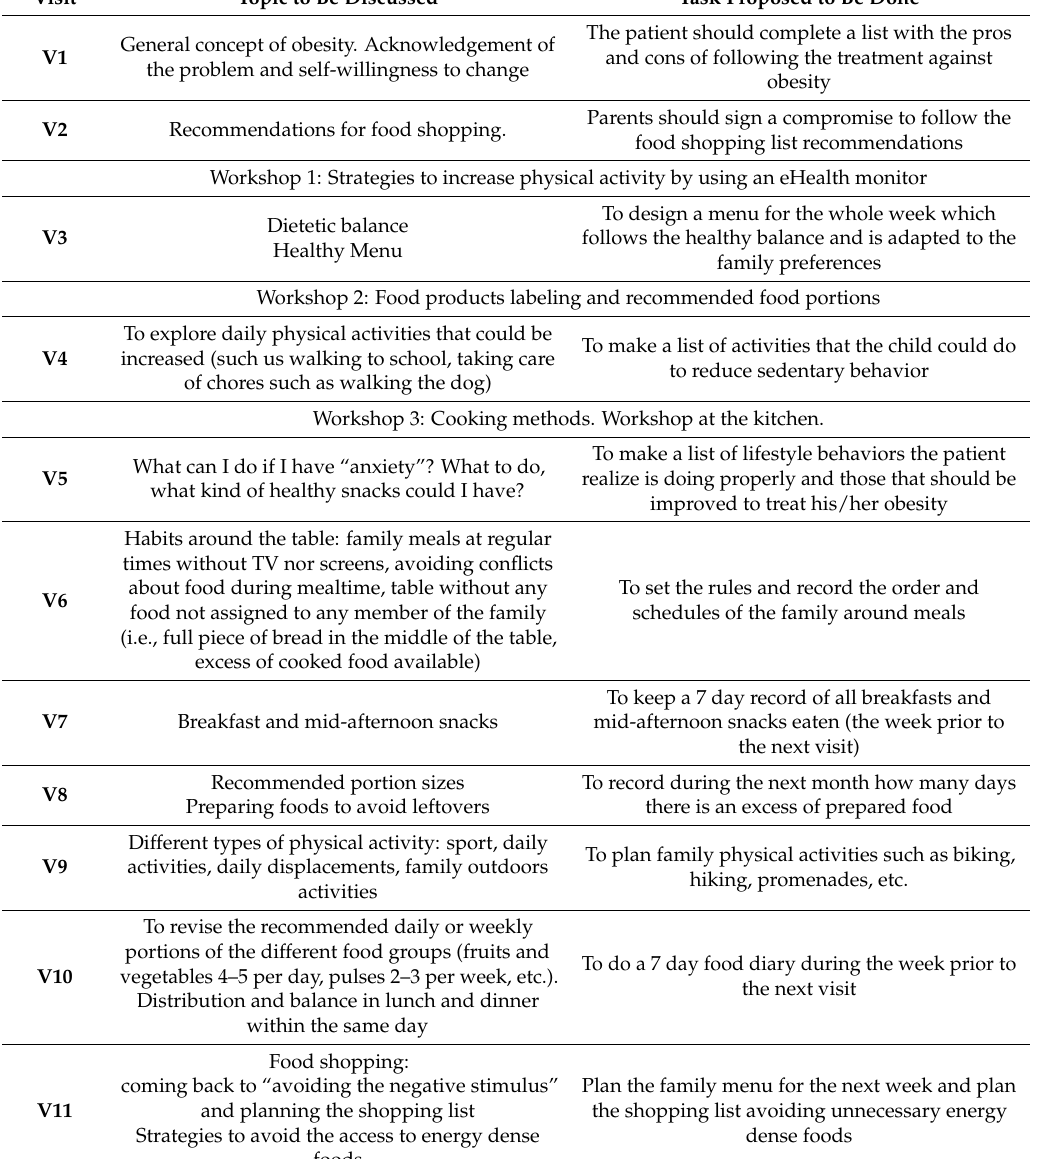
Table 1. Obemat2.0 intervention